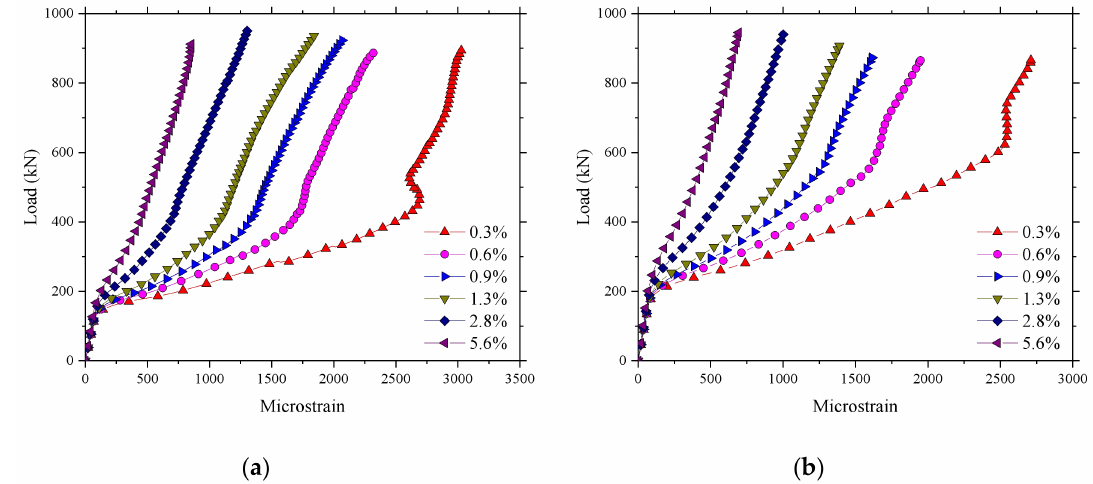
Figure 23. Influence of the reinforcement ratio on the strain of reinforcement. ( a ) Loading between the W-beams; ( b ) Loading between W-beams and